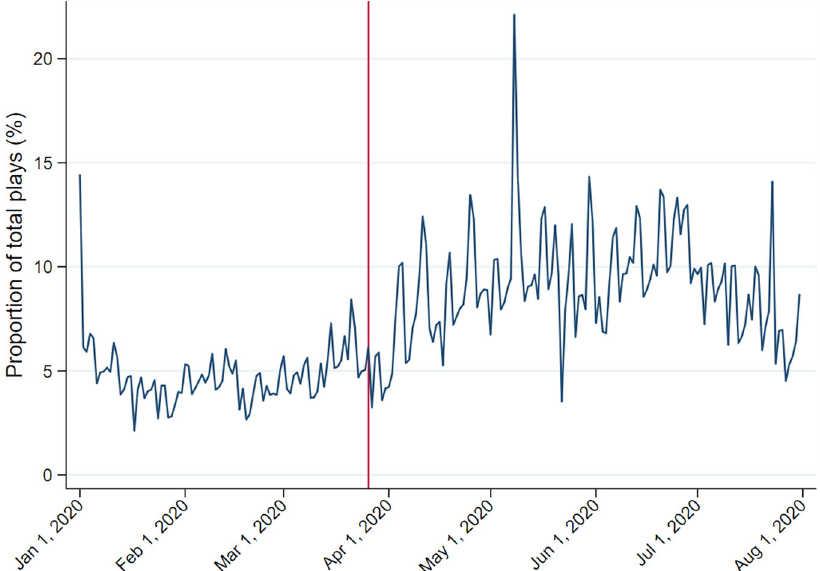
Fig. 2 UK daily plays expressed as a proportion of all plays of top 200 songs, January – July 2020. Note : The vertical reference line indicates the beginning of lockdown on 26 March 2020. Source :